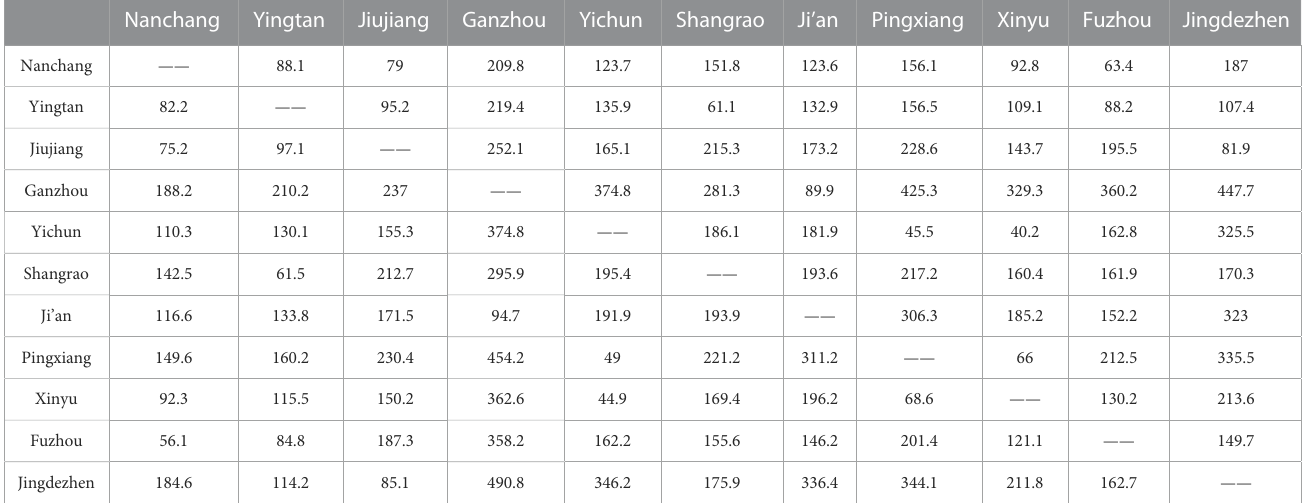
TABLE 6 Economic distance between cities without high-speed